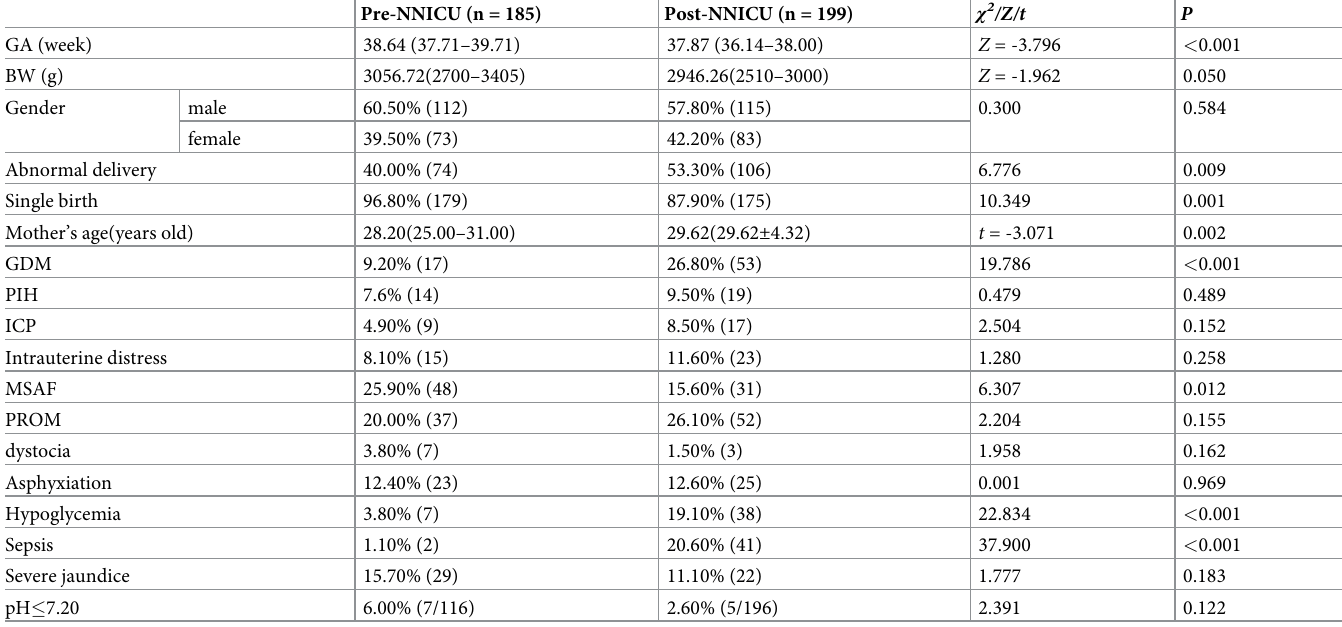
Table 1. Demographic features and risk factors of the neonates.